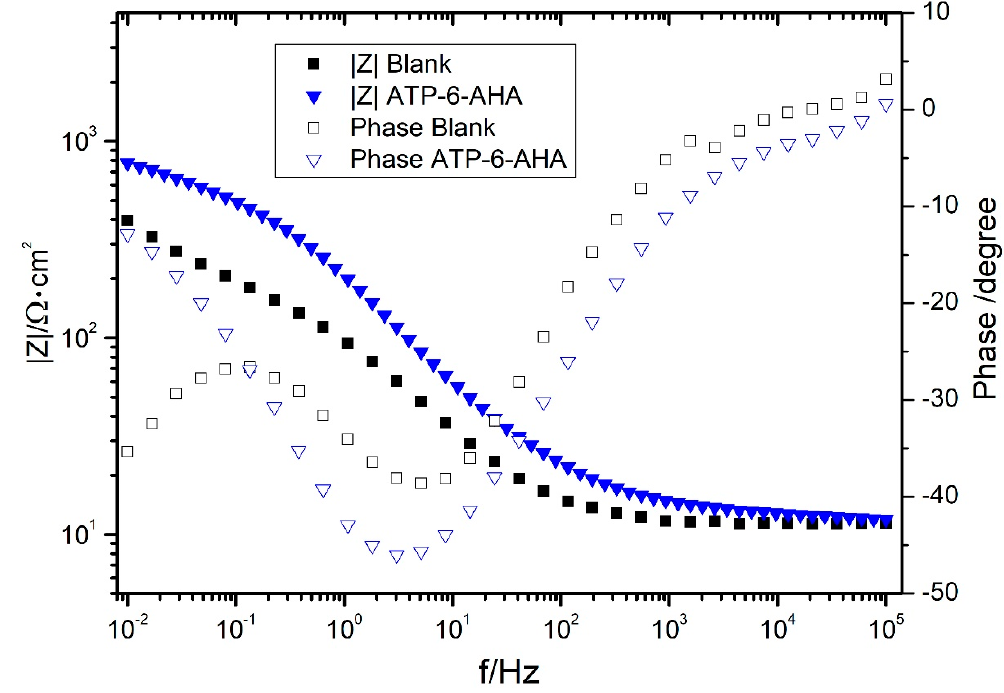
Figure 3. Bode diagram of S235 low carbon steel after 20 h of immersion time in 3.5% NaCl with and without ATP-6-AHA.